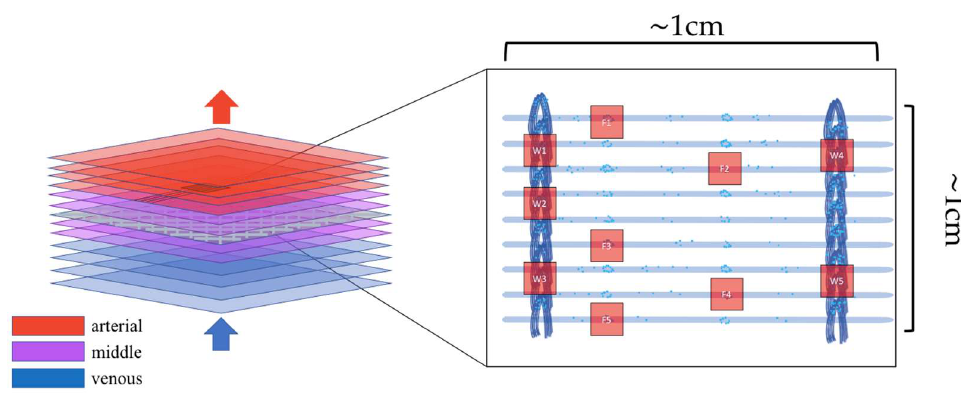
Figure 1. The figure shows a schematic representation of the hollow fiber mat layering within the Maquet PLS-I oxygenator ( left ). The layers are assigned to the venous, middle, and arterial sides. An examined area from the middle part of the oxygenator has been enlarged as an example ( right ). Two arrows (blue and red) indicate the direction of blood flow through the membrane stack. It shows a prepared hollow fiber mat with cell nuclei (blue dots). The entire hollow fiber mat was scanned by epifluorescence microscopy at 40× magnification, and five representative spots with increased cell deposition on the hollow fibers and the warps connecting the hollow fibers were set for confocal Z-scans (red squares). Table 1. Z-scan range of cell adhesions at different predilection sites in the investigated MO. Predilection Site